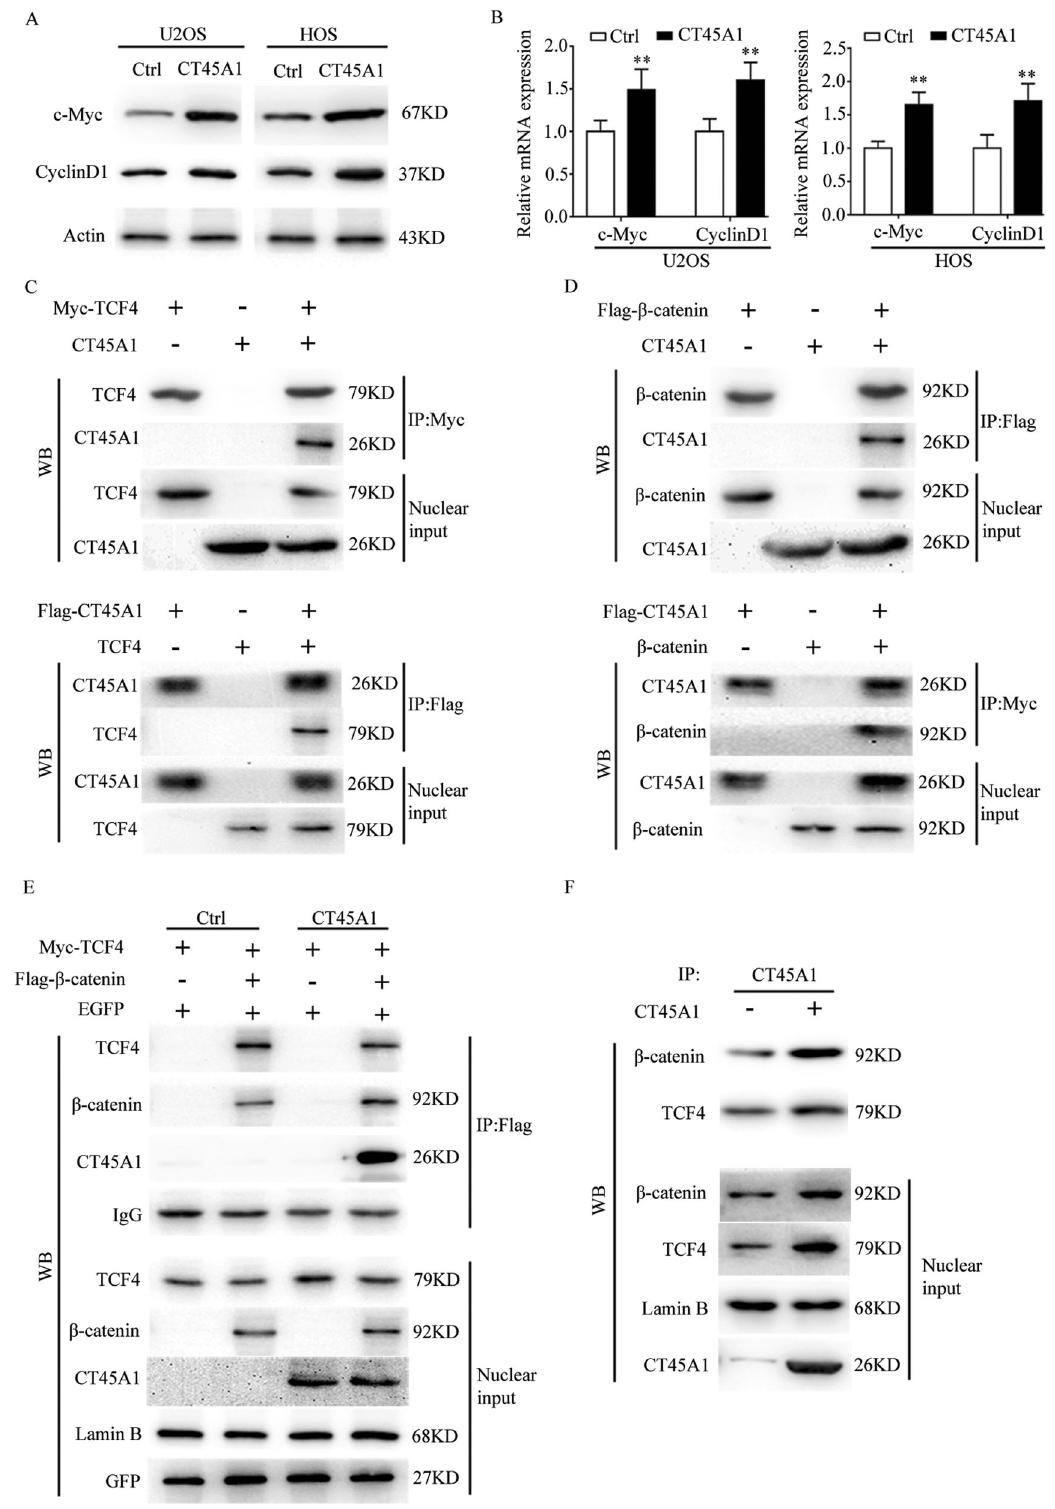
Fig. 6 CT45A1 activates β -catenin through participating in formation of the transcriptional complex of β -catenin. A Western blotting for the quanti fi cation of c-Myc and CyclinD1 protein expressions in osteosarcoma cell lines. B qRT-PCR for the quanti fi cation of c-Myc and CyclinD1 protein expressions in osteosarcoma cell lines. C Co-IP analysis between CT45A1 and TCF4. D Co-IP analysis between CT45A1 and β -catenin. E Co-IP analysis between TCF4 and β -catenin under the condition of CT45A1 overexpression. F Co-IP analysis between CT45A1 and TCF4 、 β -catenin. ** P < 0.01, compared to the control. The error bars indicate the means ± SDs.